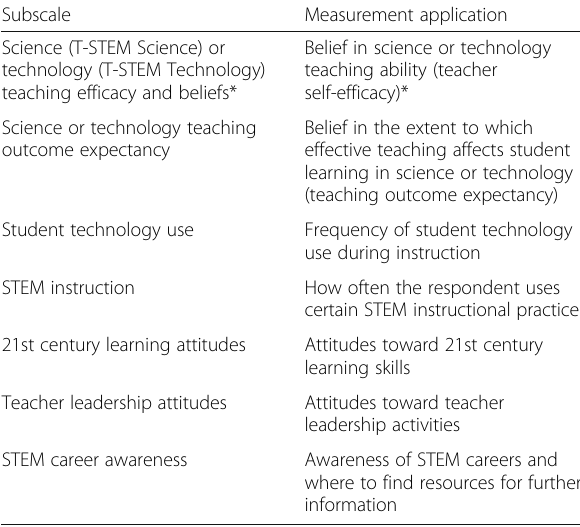
Table 3 T-STEM Survey Subscale Summary (T-STEM Science